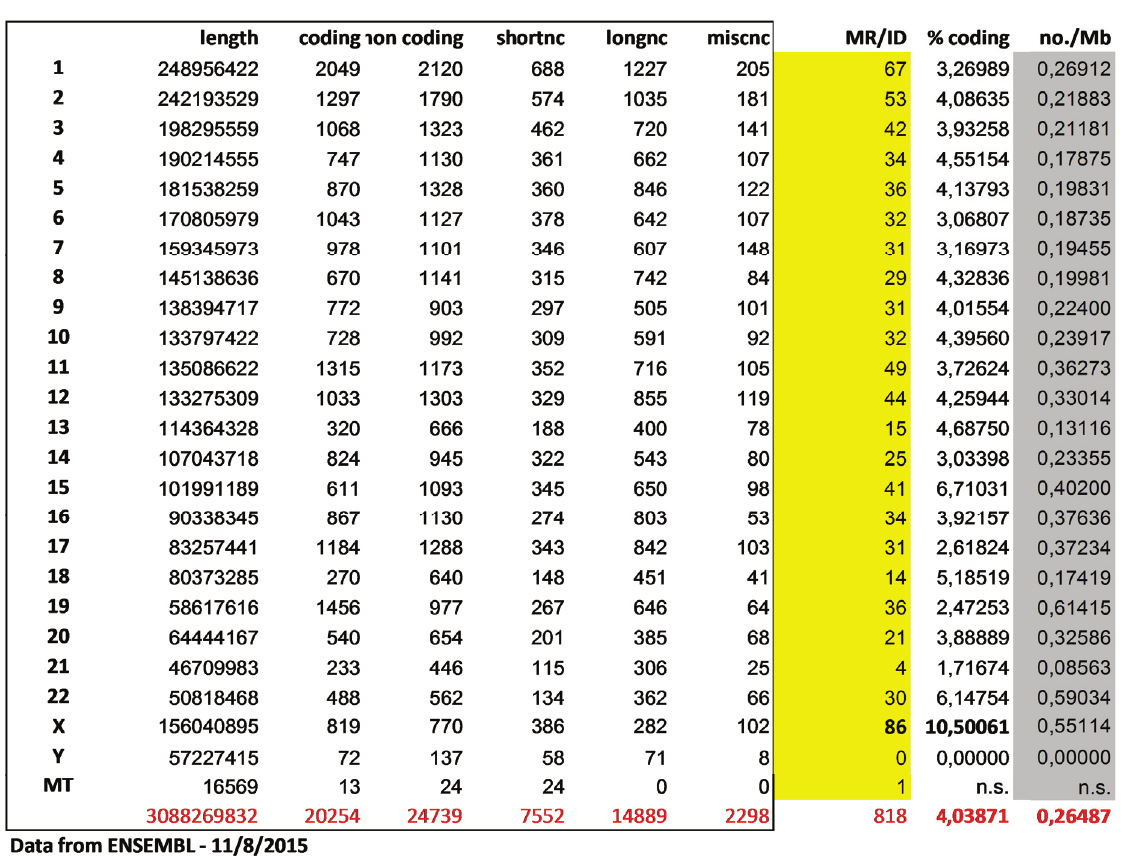
Figure 5. Distribution of intellectual disability genes per chromosome and comparison with the total amount of protein-coding and non-coding genes located on each chromosome. longnc, long non-coding; Mb, megabase; miscnc, miscellaneous non-coding; MR/ID, known mental retardation/intellectual disability genes; shortnc, short